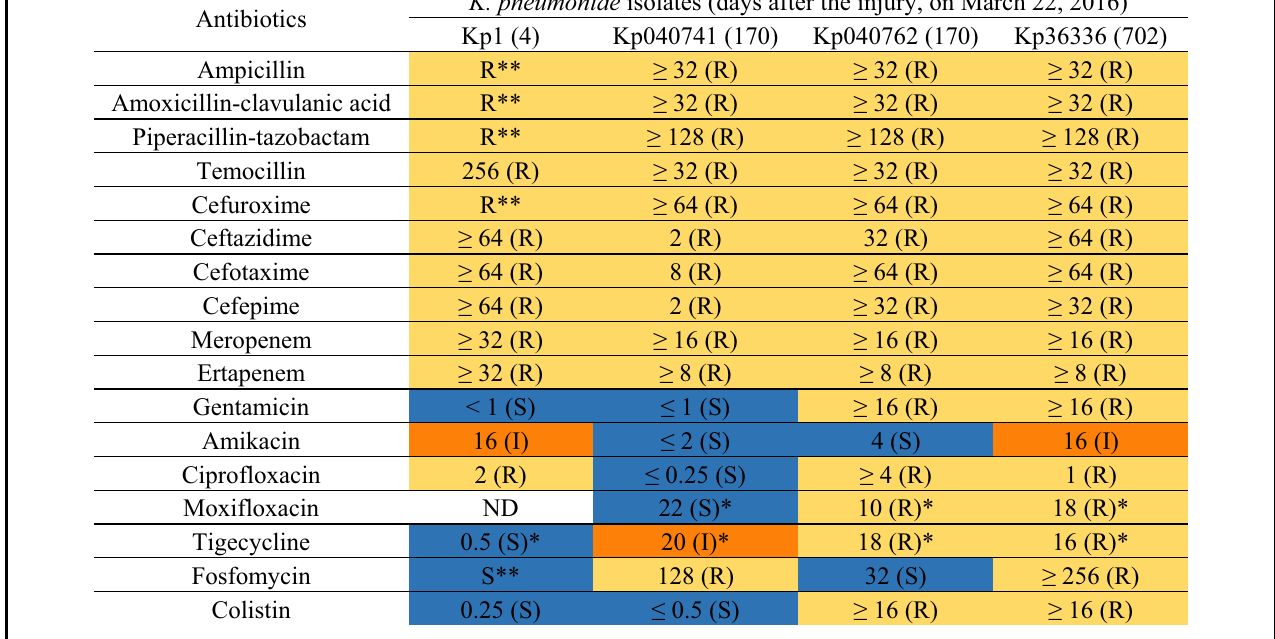
Table 1 Minimum inhibitory concentrations (MICs, μ g/ml) and EUCAST-based categorization of the susceptibility (using the VITEK 2 system) of a selection of the patient ’ s Klebsiella pneumoniae isolates to a selection of